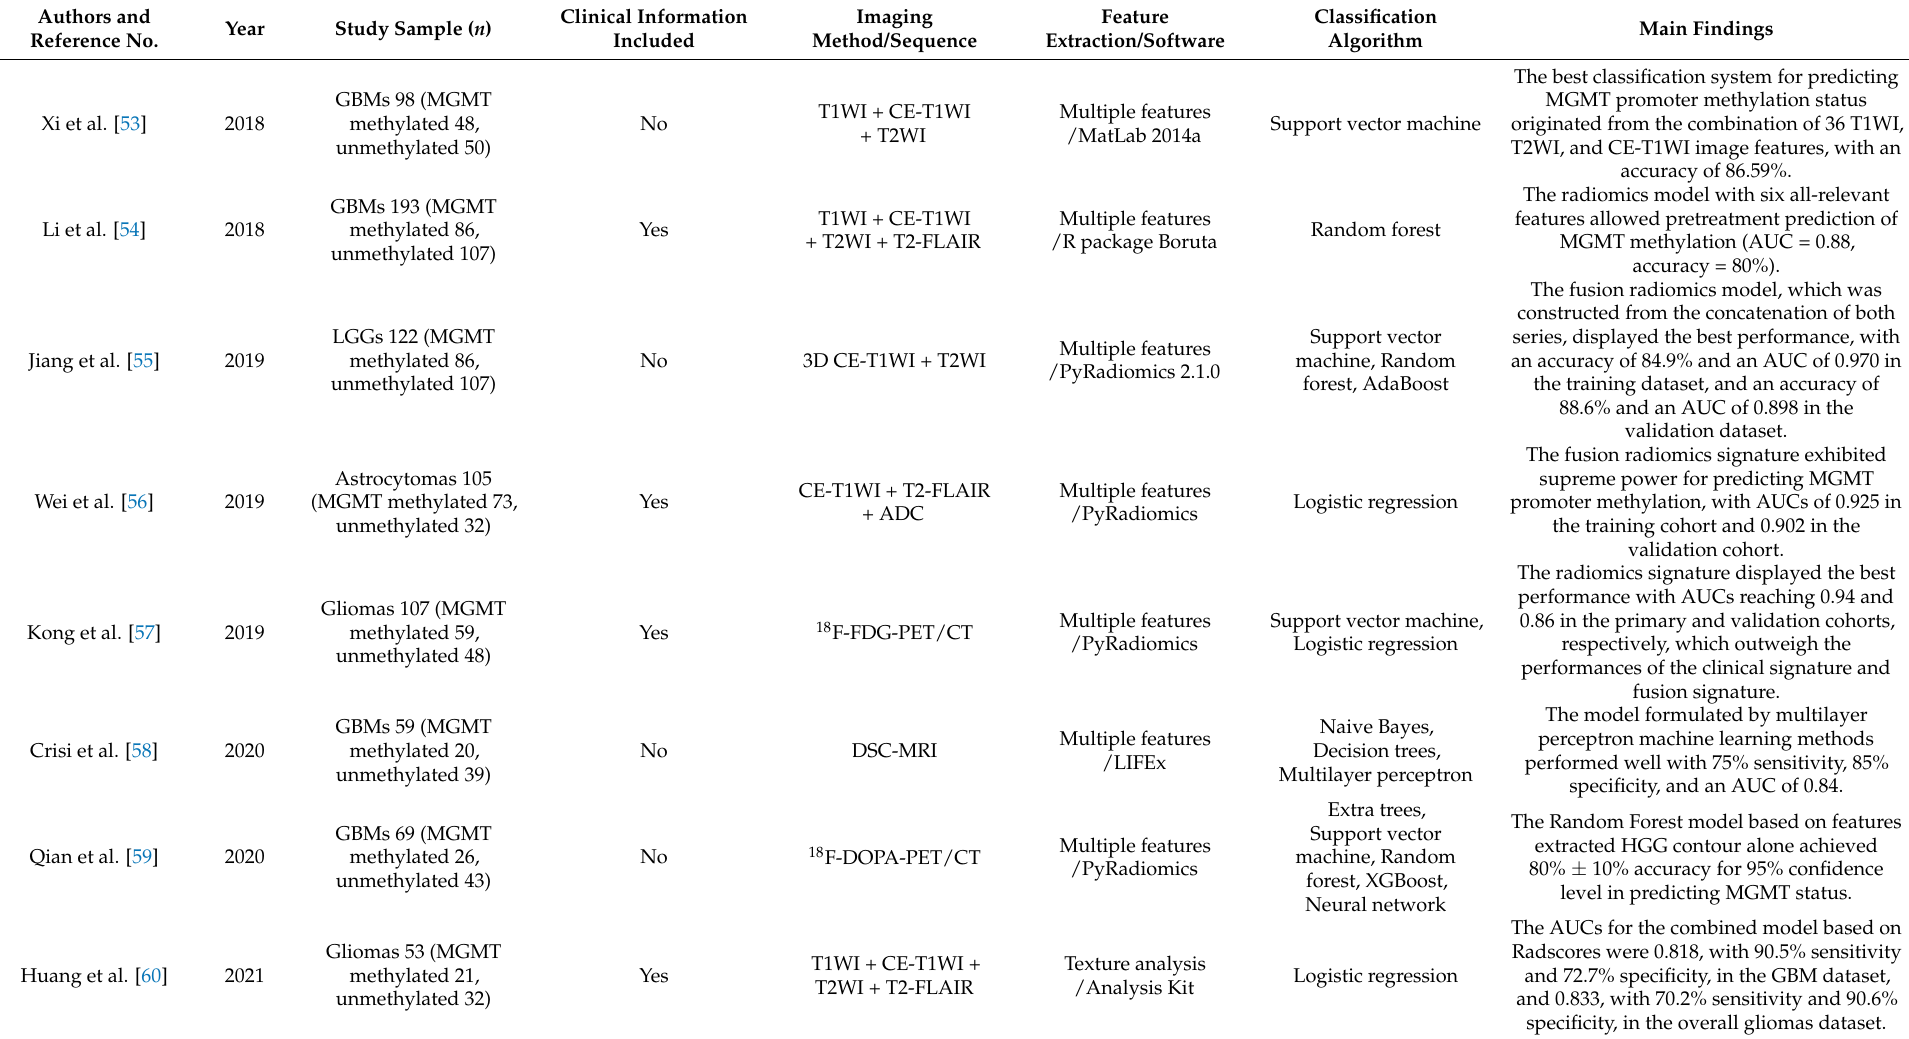
Table 4. Studies Investigating the Role of Radiomics in Predicting MGMT Promoter Methylation